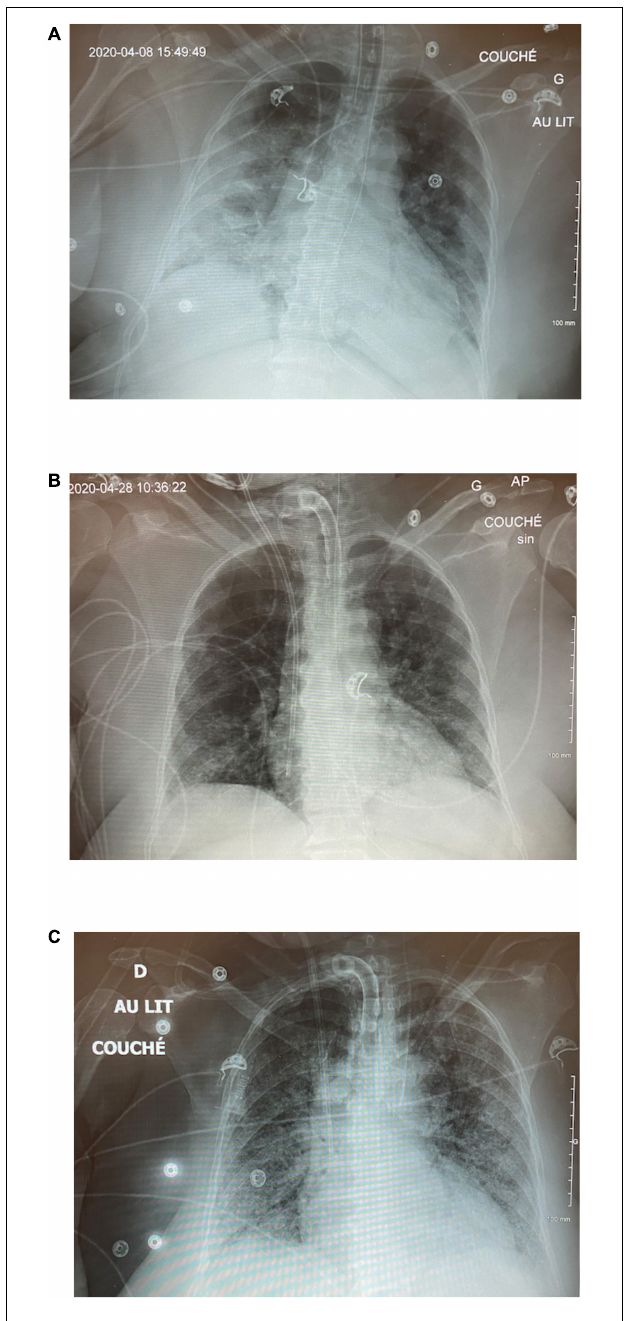
FIGURE 3 | Case 1: (A) CXR on ICU day 2 on PCV. (B) CXR on day 17 post-tracheostomy. (C) CXR following switch to